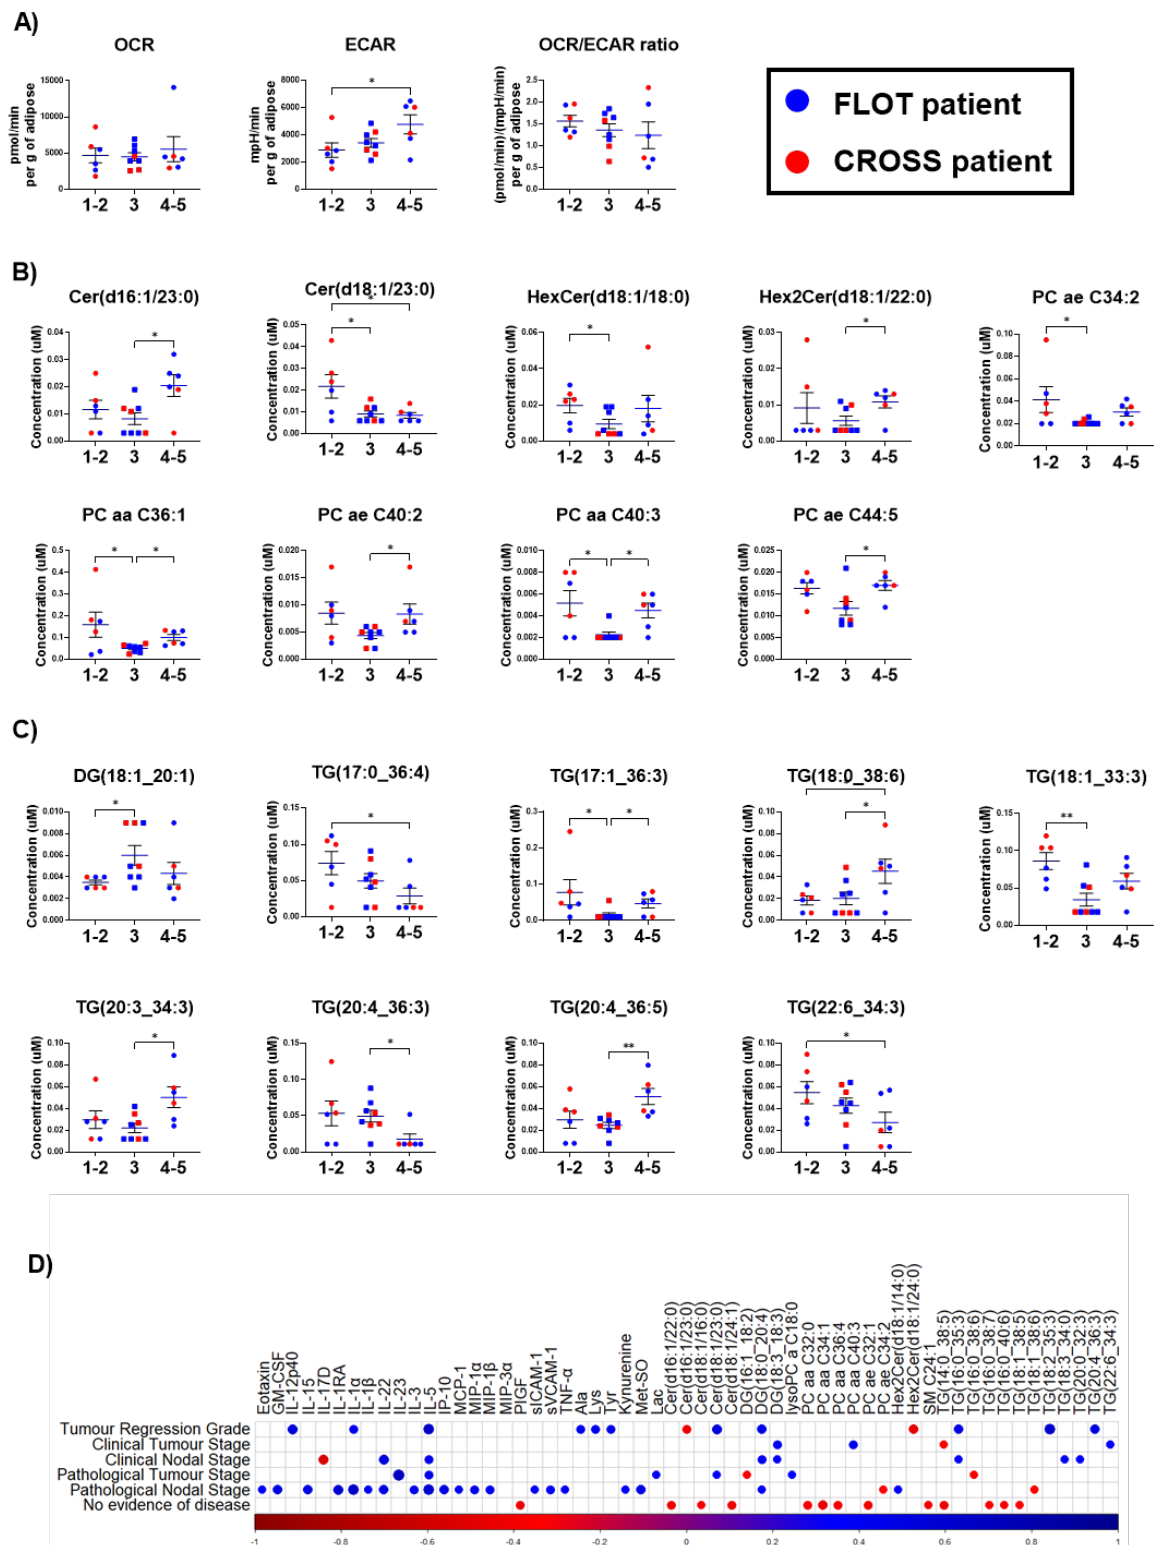
Figure 4. Increased ECAR and altered metabolites are observed in adipose explants from OAC patients with increasing tumour regression grades. ( A ) OCR, ECAR, and OCR:ECAR ratio (Kruskal– Wallis with Dunn’s correction). ( B ) Cer(d16:1/23:0), Cer(d18:1/23:0), PC aa C36:1, PC aa C40:3, PC ae C34:2, PC ae C40:2, PC ae C44:5, Hex2Cer(d18:1/22:0), and HexCer(d18:1/18:0) (Kruskal–Wallis